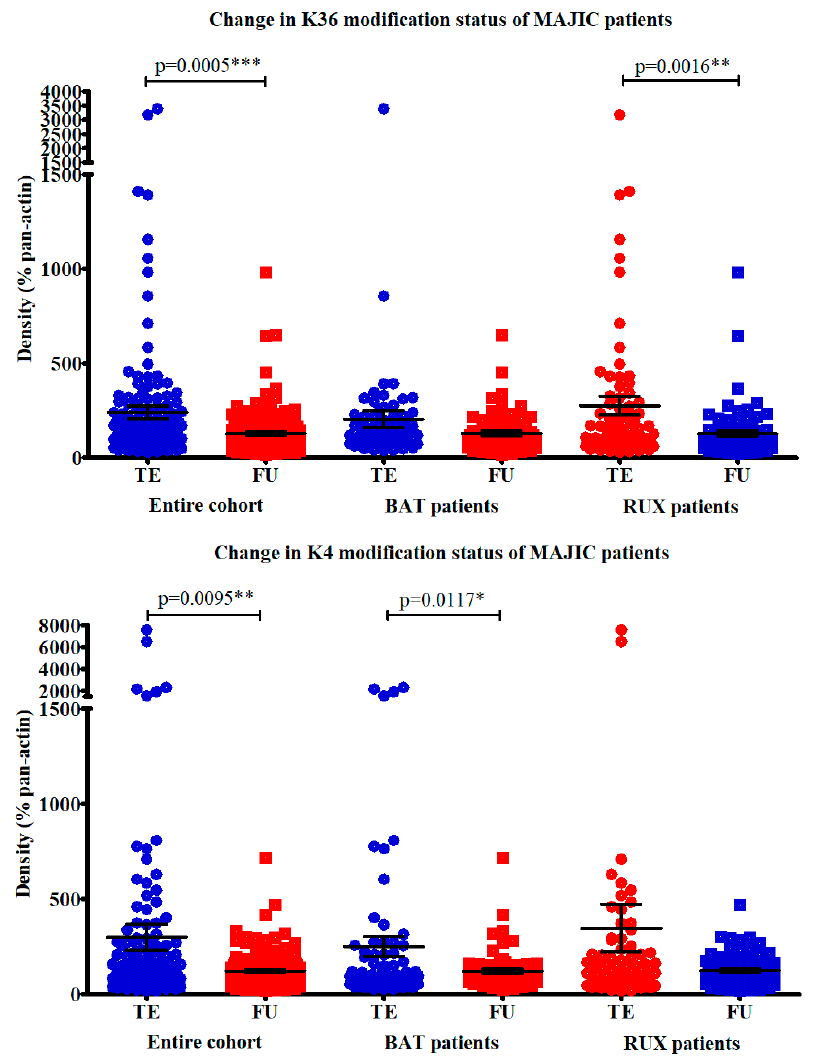
Figure 5. Change in histone modification status of MAJIC patients—both sets of histone modifications were significantly decreased in follow-up (FU) samples, compared to those at trial entry